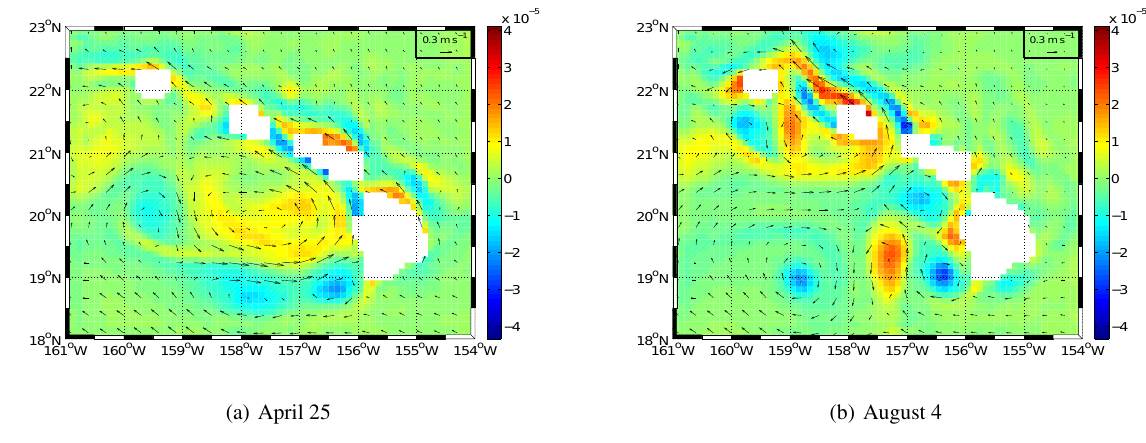
Fig. 7. Relative vorticity field and velocity vectors at 10-m depth on April 25 (left) and August 4 (right) for Run-D.